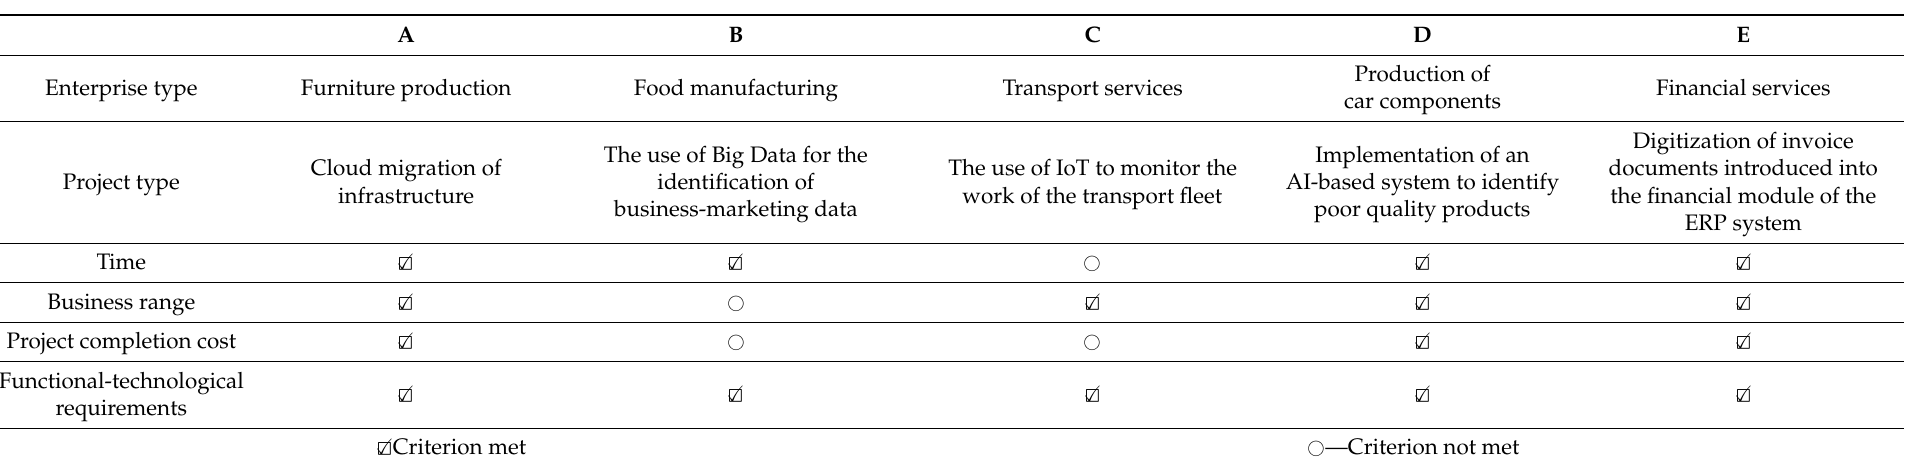
Table 6. Project effectiveness criteria. Source: Own